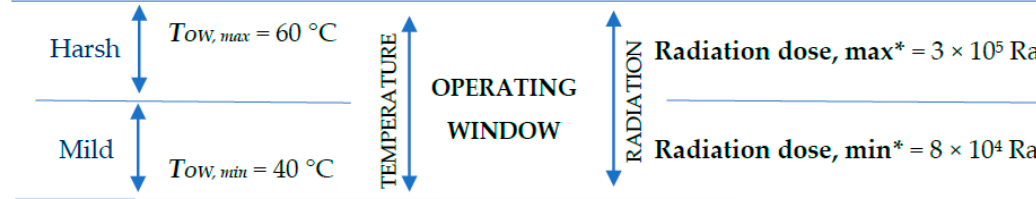
Figure 3. Temperature operating window in mild environment plus radiation (considering normal conditions). Note (*): Main pumps room usual radiation.